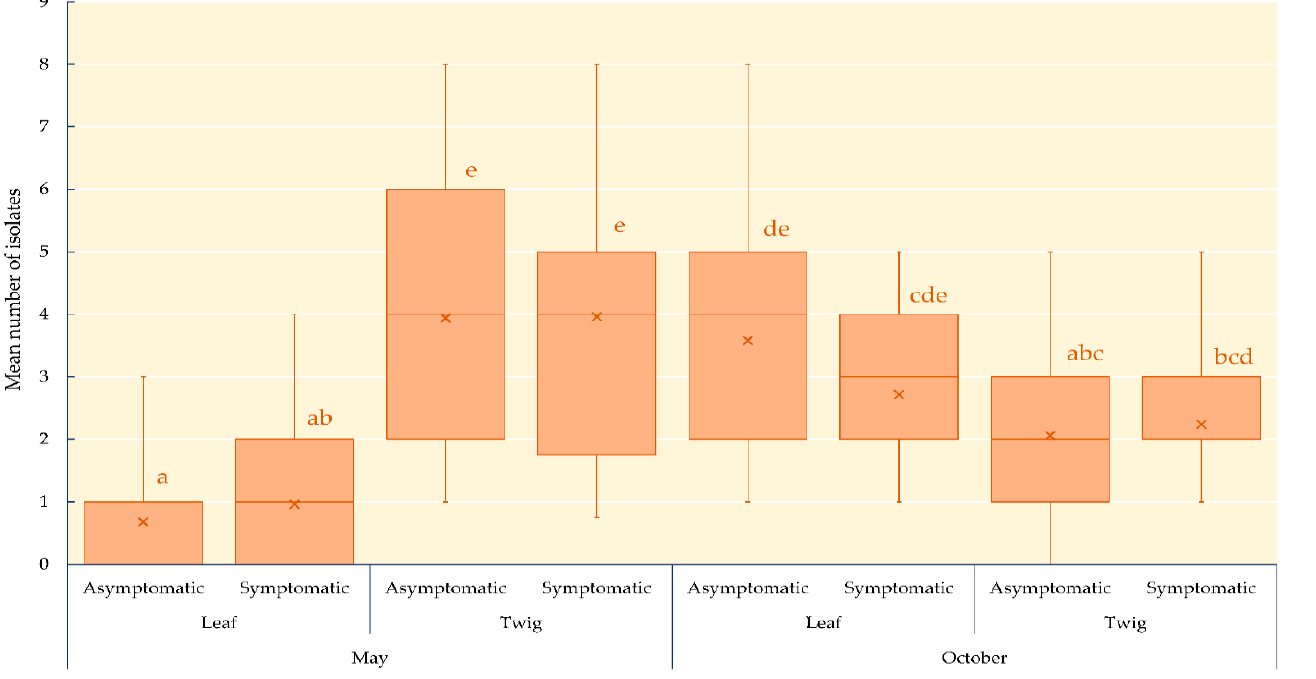
Figure 1. Box and whisker plot showing the mean number of isolates of endophytic fungi per tissue sample (leaves or twigs) of ash trees displaying (symptomatic) or not displaying (asymptomatic) symptoms of ash dieback disease collected in May and October 2019; mean values indicated by the same letter are not significantly different (Tukey HSD test; p = 0.05).